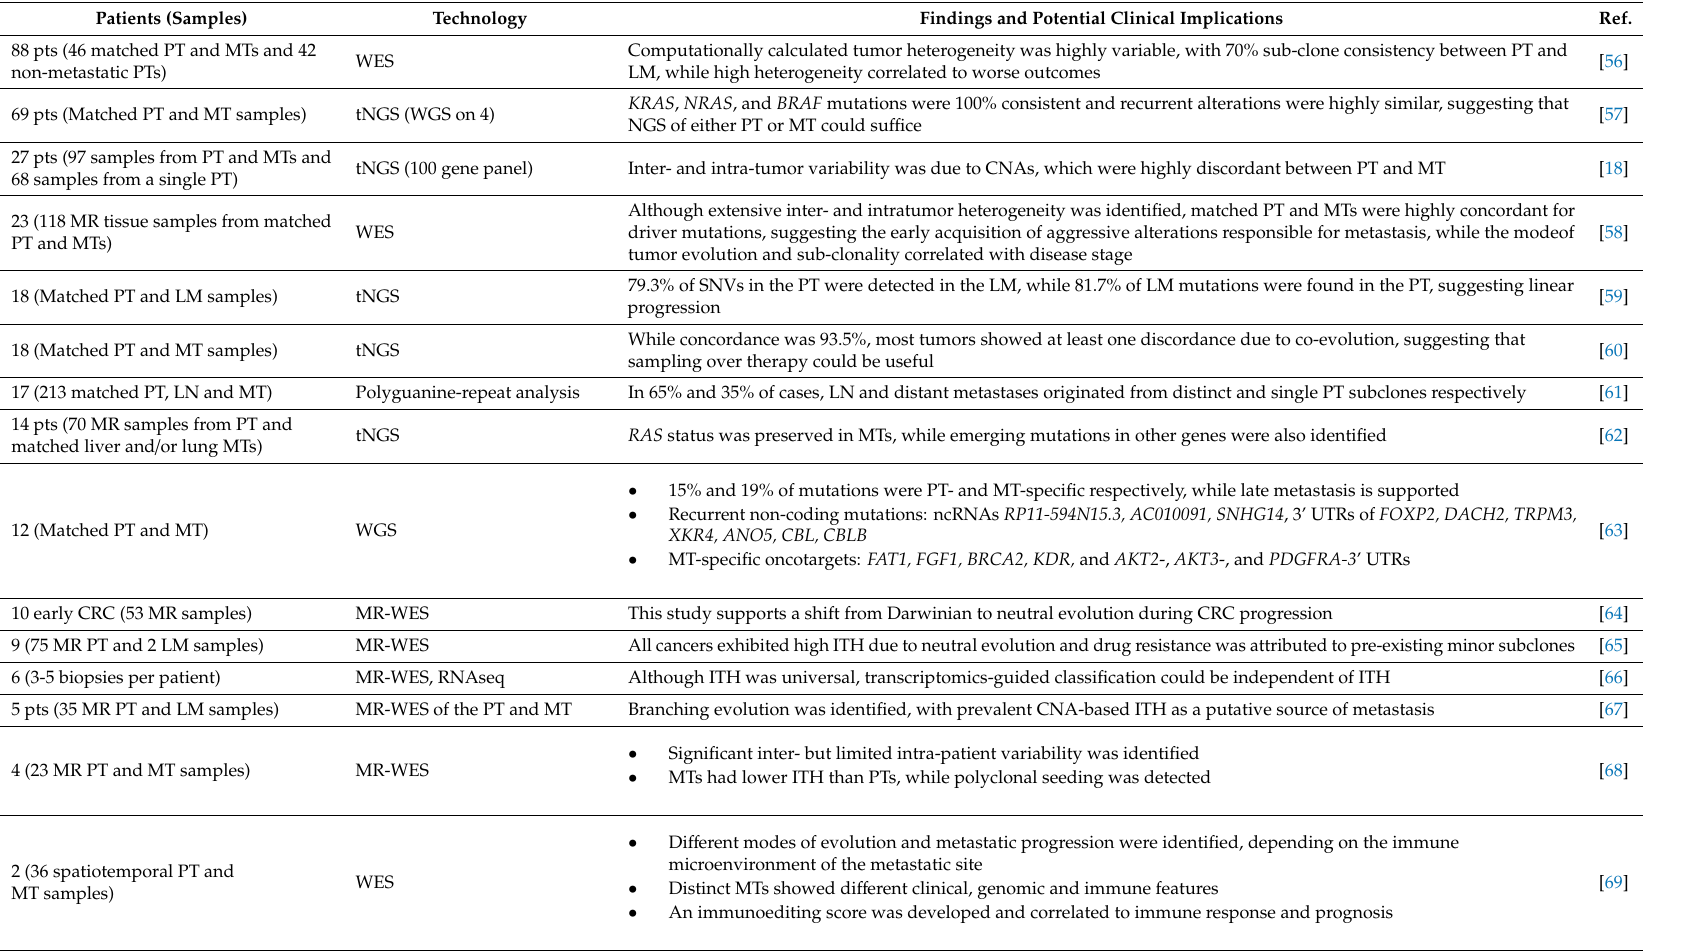
Table 2. Multiple biopsy next-generation sequencing dissecting tumor